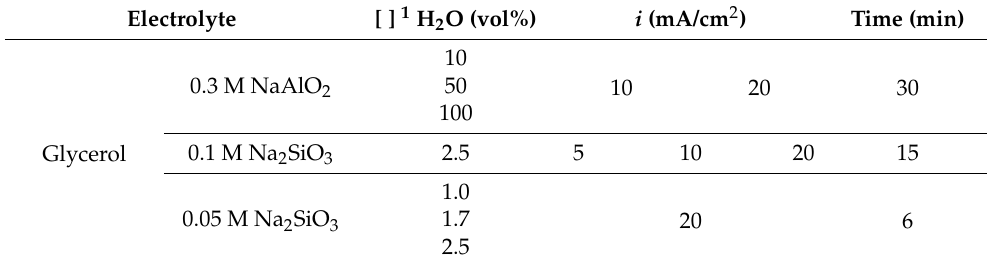
Table 1. The chemical compositions of the electrolytes and the anodizing conditions used for the fabrication of the oxide layers on 304L